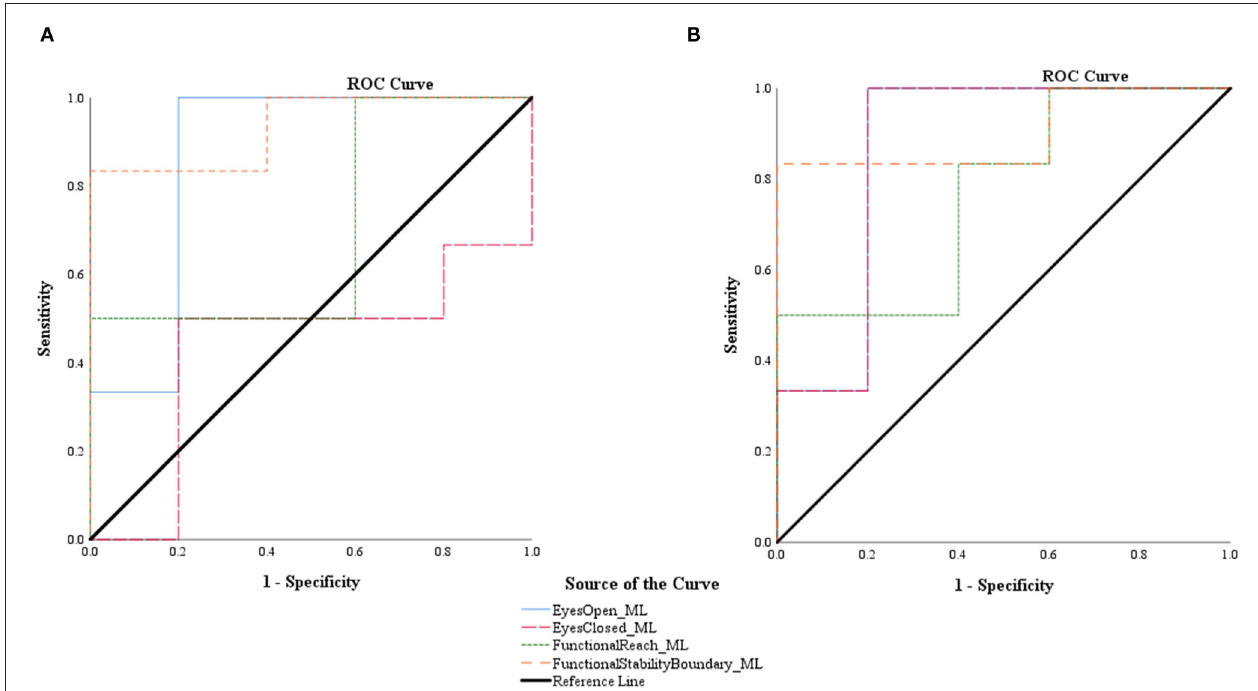
FIGURE 2 | Receiver operating characteristic (ROC) curves for root mean squared smartphone (A) and research-grade accelerometer (B) acceleration in the medial-lateral (ML) direction during all balance